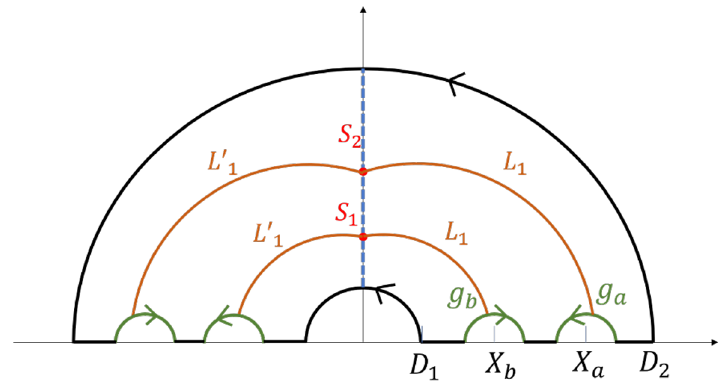
Figure 26 . The brown geodesic in figure 2 with two intersection points s 1 , s 2 on the horizon M 3 is depicted in this covering space. This covering space has a Z 2 symmetry with respect to the vertical dashed blue line M 3 , so we only have to consider the right half. L 1 consists of two arcs. The larger one is part of a large semicircle which is the image of γ 2 (A.6) applied to the smaller semicircle that includes the smaller arc of L 1 . The two brown arcs are joint smoothly under the identification of the green semicircles. This type of geodesic is unique once we fix the intersection points s 1 and s 2 , so we can move s 1 , s 2 to obtain the minimal